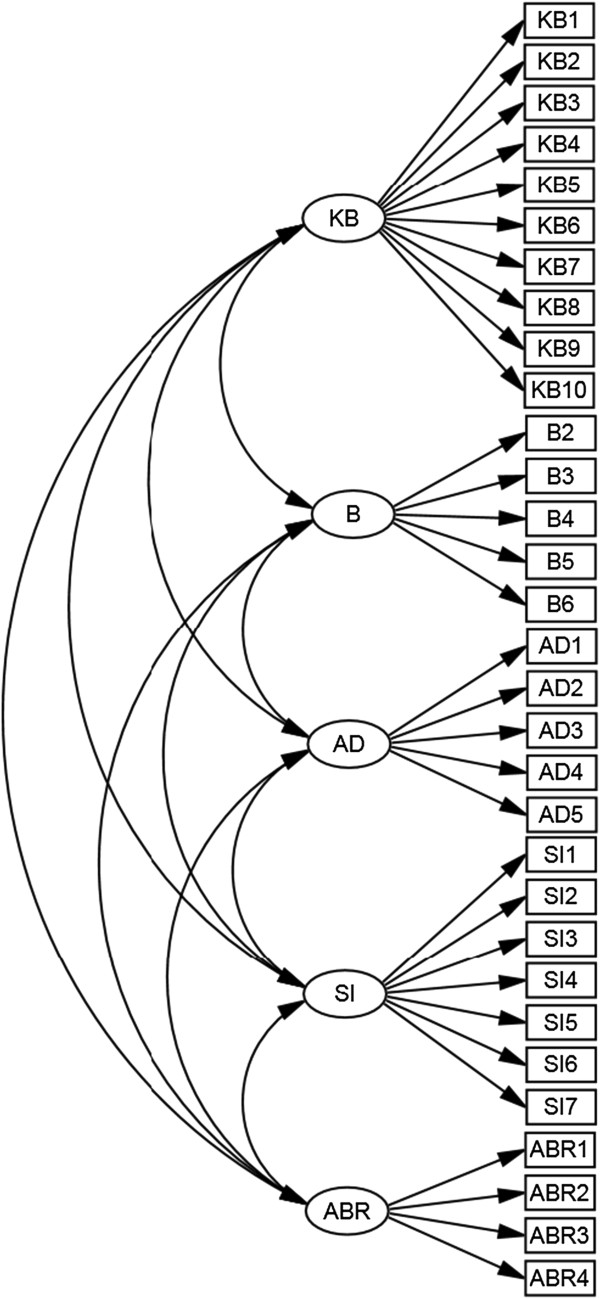
Confirmatory Factor Analysis model.